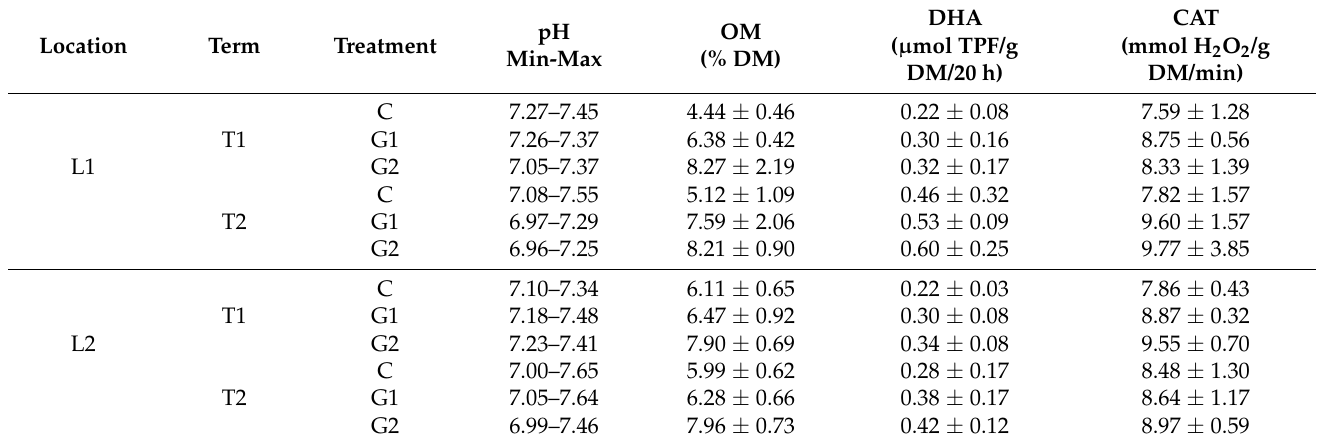
Table 2. Selected properties of soil samples from control plots (C) and treated with sewage sludge in a dose of 14.5 t DM/ha (G1) and 29 t DM/ha (G2) in L1 and L2, collected in first (T1) and second (T2) year of study.